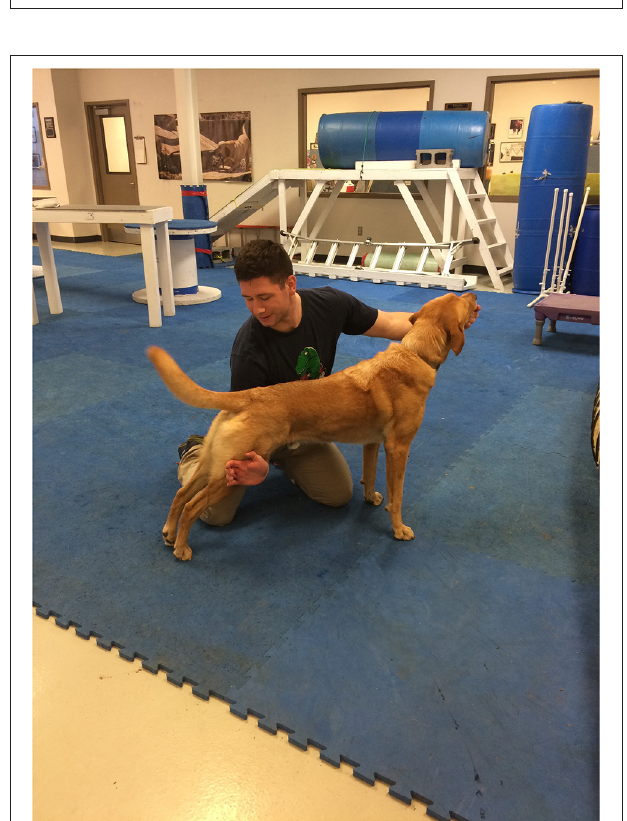
FIGURE 2 | Counter